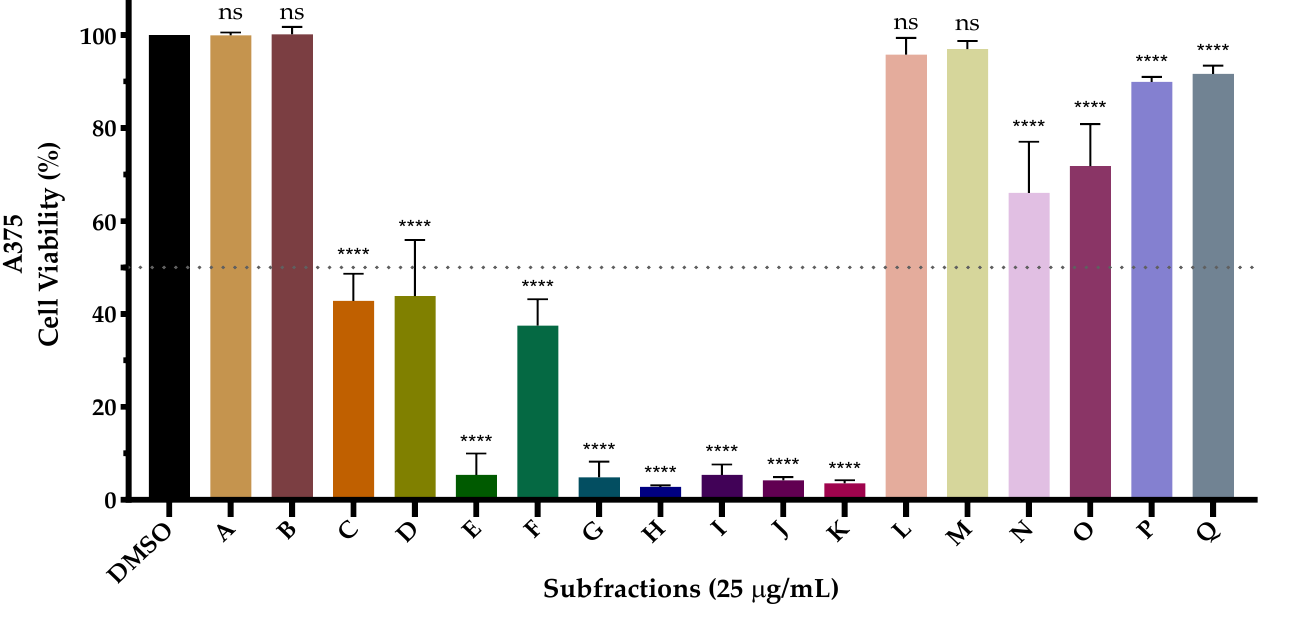
Figure 3. Effect of 25 µ g/mL of each subfraction on A375 cell biomass. Cell biomass was measured at 72 h by SRB assay after treatment with the 17 subfractions. Data were normalized to the control condition. The results are presented as mean ± SD (n ≥ 3). The statistical differences are in regard to the control, where “ns” means not significant and **** p < 0.0001.